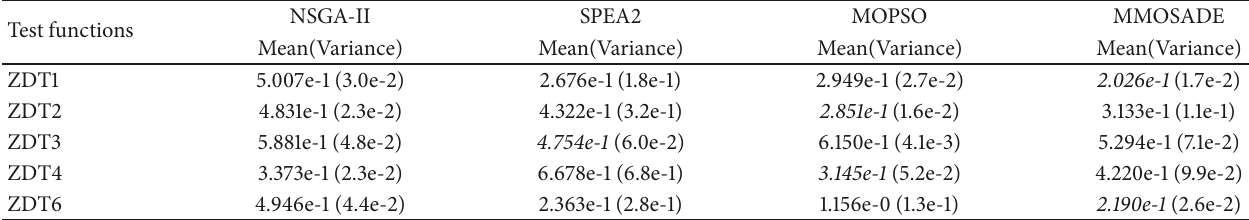
Table 2: Test results of